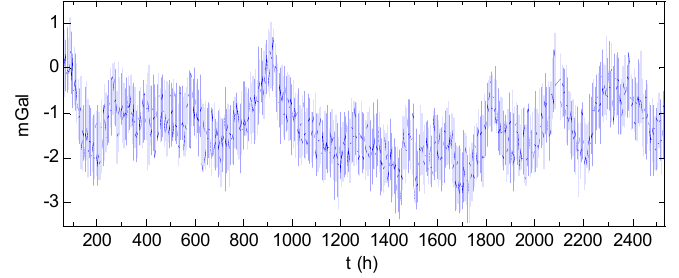
Figure 10. Result after the drift was compensated using a quadratic curve (after subtracting the starting value).